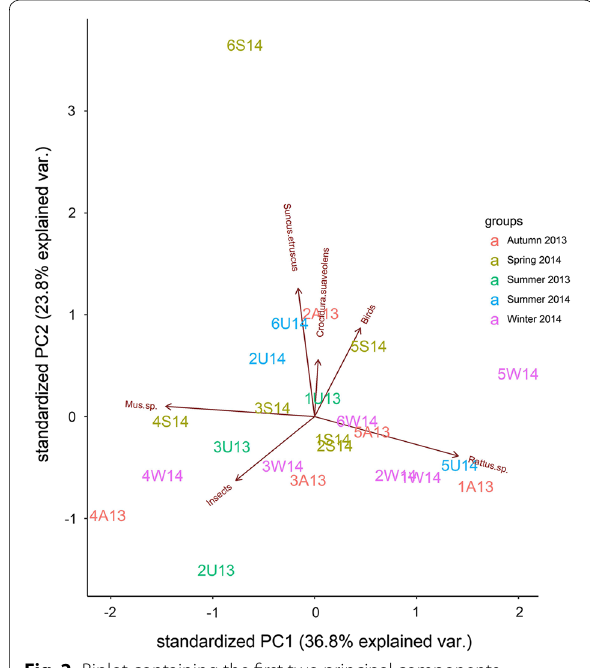
Fig. 2 Biplot containing the first two principal components presenting the differentiation of barn owl prey according to habitat. Symbol meaning: 1: Mountain with pine trees and maquis; 2: Lowlands with agricultural crops; 3: Hilly areas with crops and livestock facilities; 4: Areas with dry vegetation; 5: Mountain areas with vineyards and olive trees; 6: Lowlands with maquis vegetation. Different colours denote the 5 different sampling periods during 2013–2014. A Autumn, W Winter, S Spring, U Summer (i.e. 2A13 Samples from lowlands with agricultural crops during autumn = of